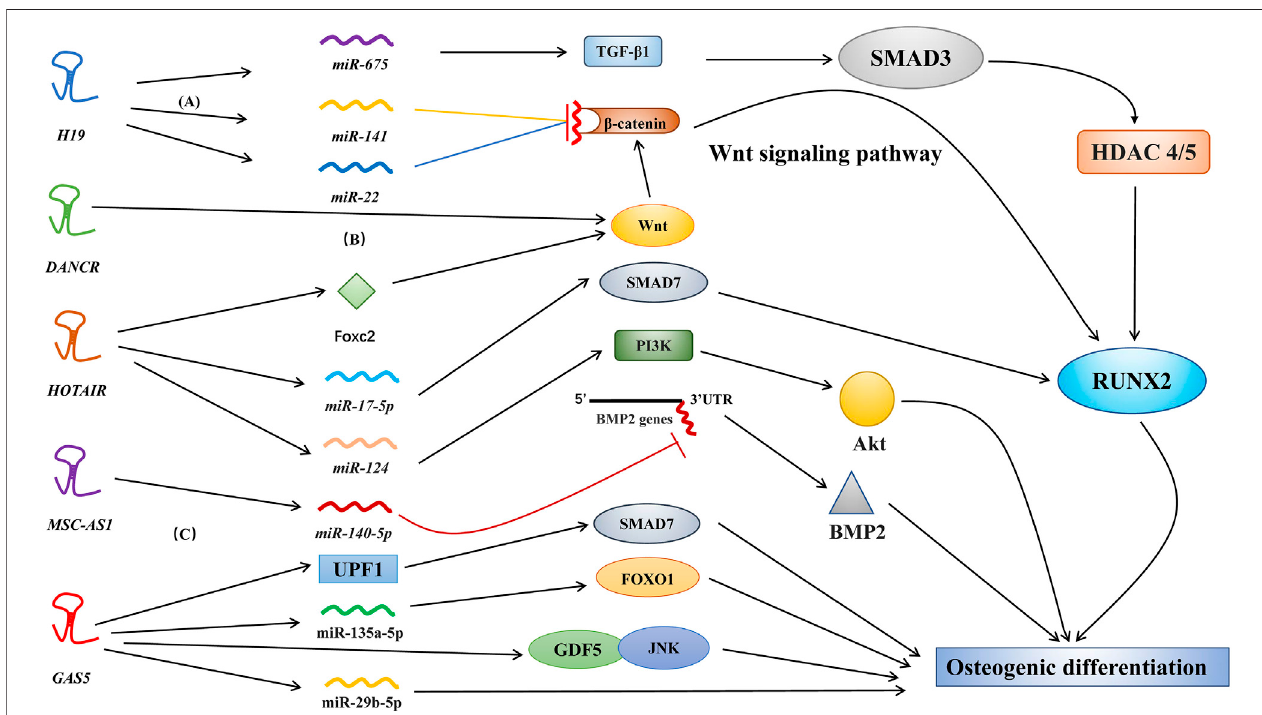
FIGURE 2 | Different molecular pathways of lncRNAs in osteogenic differentiation. Various lncRNAs, such as H19 , MALAT1 , HOTAIR , and MSC-AS1 , regulate osteogenicdifferentiationviatargetingmiRNAs. (A) H19 activelyregulatestheWntsignalingpathwaybyinhibitingthebindingof miR-141 and miR-22 to β -catenin(Gong et al., 2018). (B) DANCR regulates osteogenic differentiation via targeting the Wnt signaling pathway. However, the speci fi c factors regulated by DANCR have not yet beenidenti fi ed(Jiangetal.,2019). (C) MSC-AS1 suppressed miR-140-5p expressiontoupregulate BMP2 viainhibitionof miR-140-5p bindingtothe3 ′ UTRofthe BMP2 gene; this promotes osteogenic differentiation (Zhang et al.,